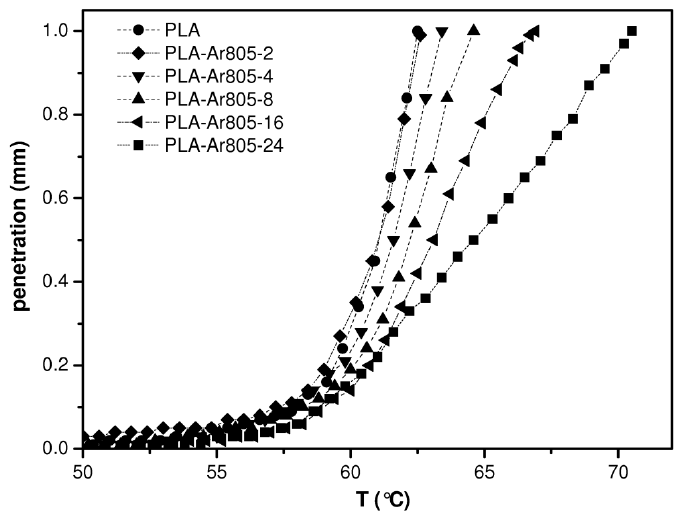
Figure 6. E ff ective particle volume fraction ( φ e , • ), and e ff ective volume per single particle (B) as a Figure 6. Effective particle volume fraction ( ф e , ● ), and effective volume per single particle (B) as a function of fumed silica volume fraction ( φ f , ), according to the Sumita model [68]. function of fumed silica volume fraction ( ф f , ○ ), according to the Sumita model [68]. (cid:35)